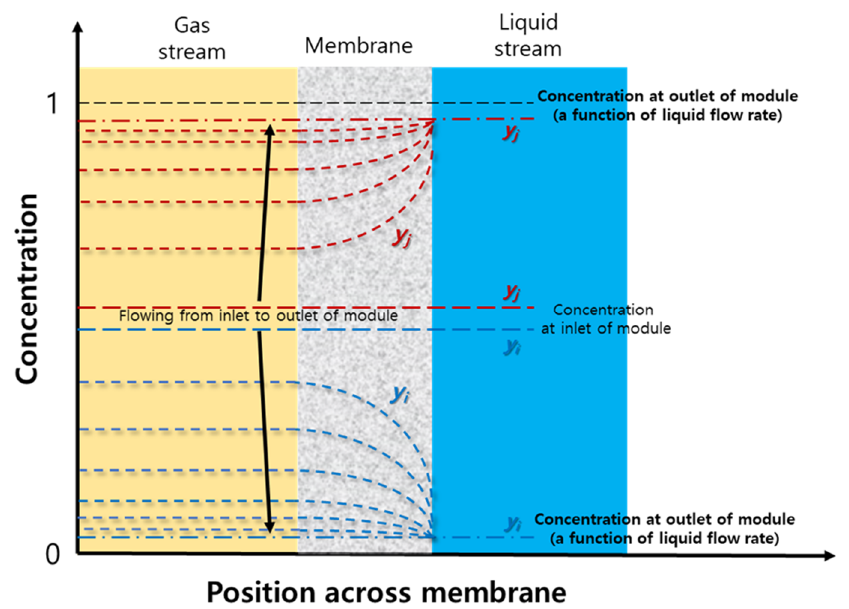
Figure 15. Schematical representation of the concentration profile of individual gas component developed in feed stream and across membrane in the gassing process for the separation of a mixture of components i/j . ( i : preferentially dissolving component to the liquid).